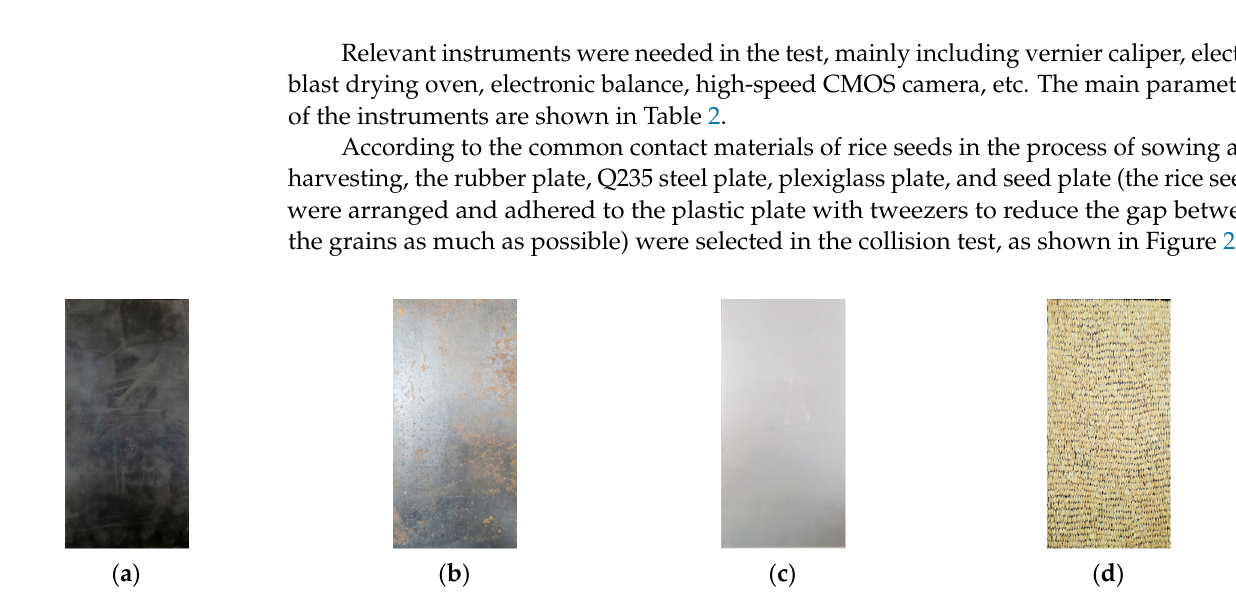
Figure 2. Contact materials: ( a ) rubber plate; ( b ) Q235 steel plate; ( c ) plexiglass plate; and ( d ) seed plate.